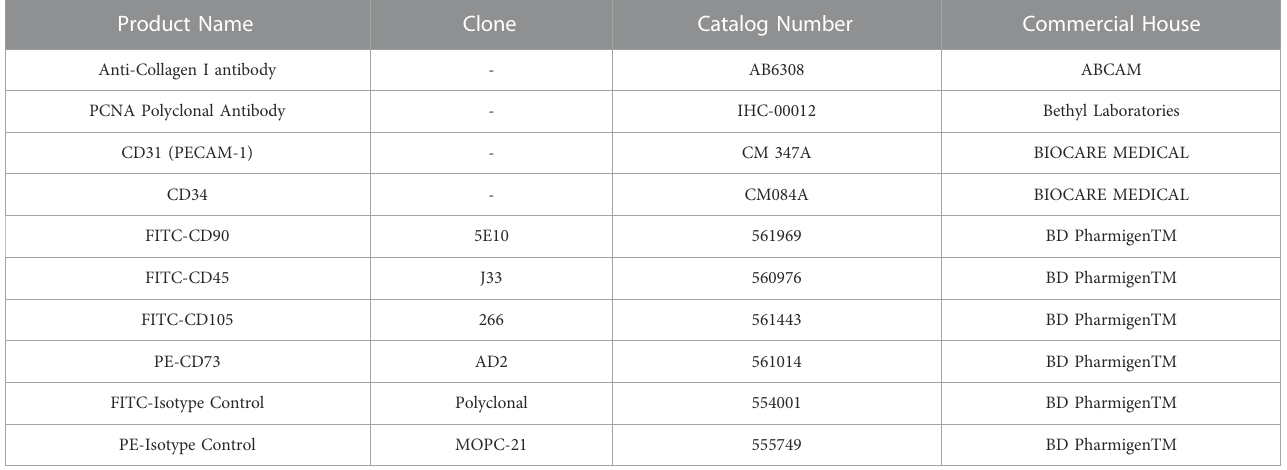
TABLE 1 Antibodies used for immunohistochemical or cyto fl uorimetric analysis.